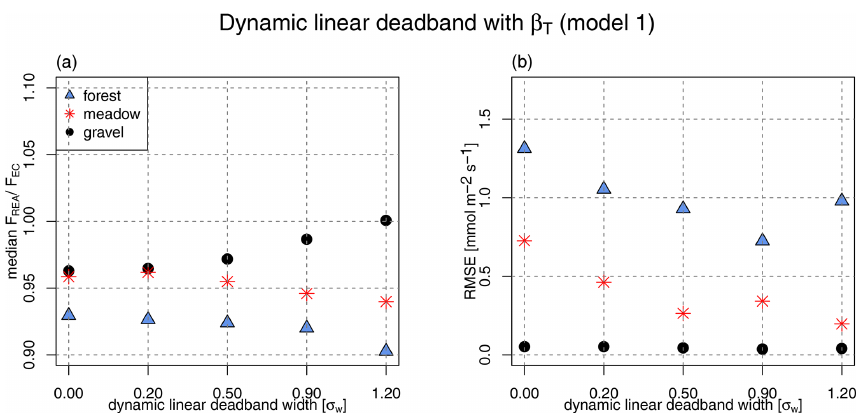
Figure 5. Errors as a function of dynamic linear deadband width. The x axis is the scaling factor a multiplied by the vertical wind standard deviation σ w in Eq. (9) to define the deadband threshold. (a) Median F REA /F EC (latent heat flux simulated with sensible heat as a proxy) ratio for each of the simulated dynamic deadband widths; (b) RMSE for each of the simulated dynamic deadband